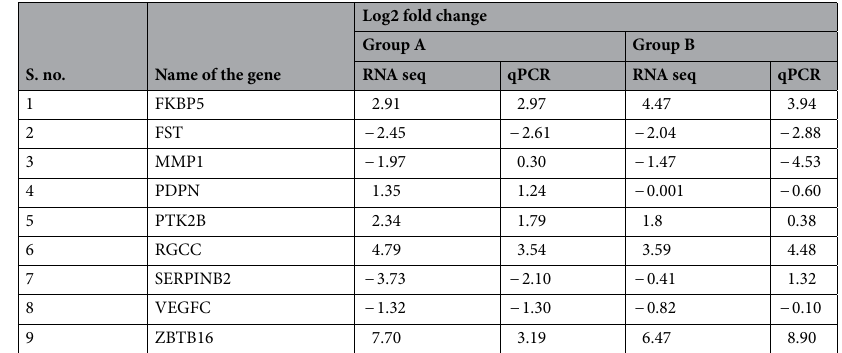
Table 2. Comparison between RNA sequencing findings and qPCR. Group A: DEGs between DEX and ETH treated 16 h; Group B: DEGs between DEX and ETH treated for 7 d. FKBP5 FK506 binding protein 5, FST follistatin, MMP1 matrix metalloproteinase-1, PDPN podoplanin; protein tyrosine kinase 2 beta, RGCC regulator of cell cycle, SERPINB2 serpin family B member 2, VEGFC vascular endothelial growth factor-C, ZBTB16 zinc finger and BTB domain containing